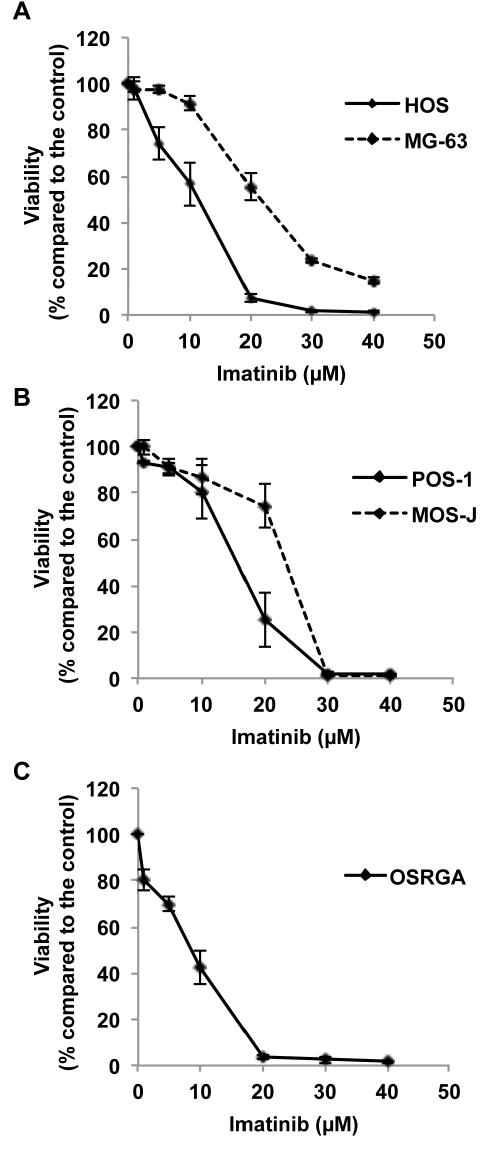
Figure 1. Imatinib mesylate inhibits in a dose dependent manner the osteosarcoma cells proliferation. Human (HOS, MG63) ( A ) , mouse ( POS-1, MOS-J ) ( B ) and rat (OSRGA) ( C ) osteosarcoma cell lines were treated by increasing concentration of imatinib mesylate (0.1–40 m M) for 72 hours. The number of viable cells was then determined using an XTT assay. ( D ) Table summarizing the IC50 and IC90 of each cell lines studied. Graphs represent the average values of three independent experiments performed in triplicate.